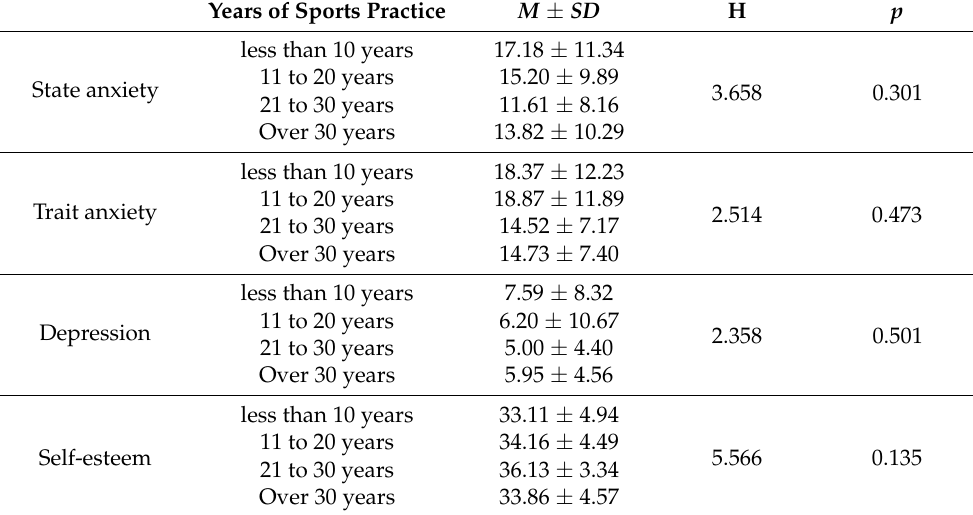
Table 7. Results for the differences in the speleologists sample according to years of